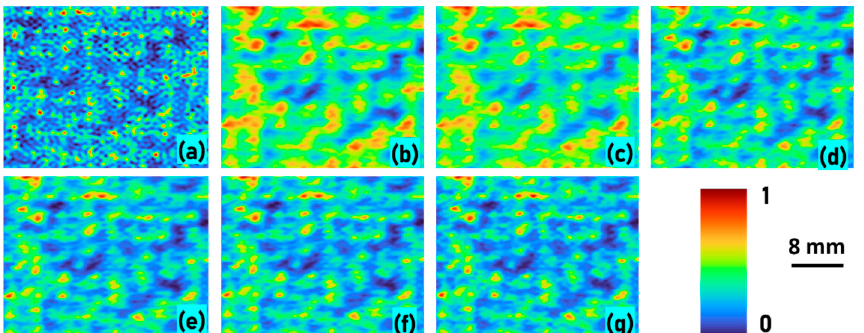
Figure 6. Experimentally recorded green PSF ( a ), object intensity distributions at t = 0 µ s ( b ), 40 µ s ( c ), 80 µ s ( d ), 120 µ s ( e ), 160 µ s ( f ) and 200 µ s ( g